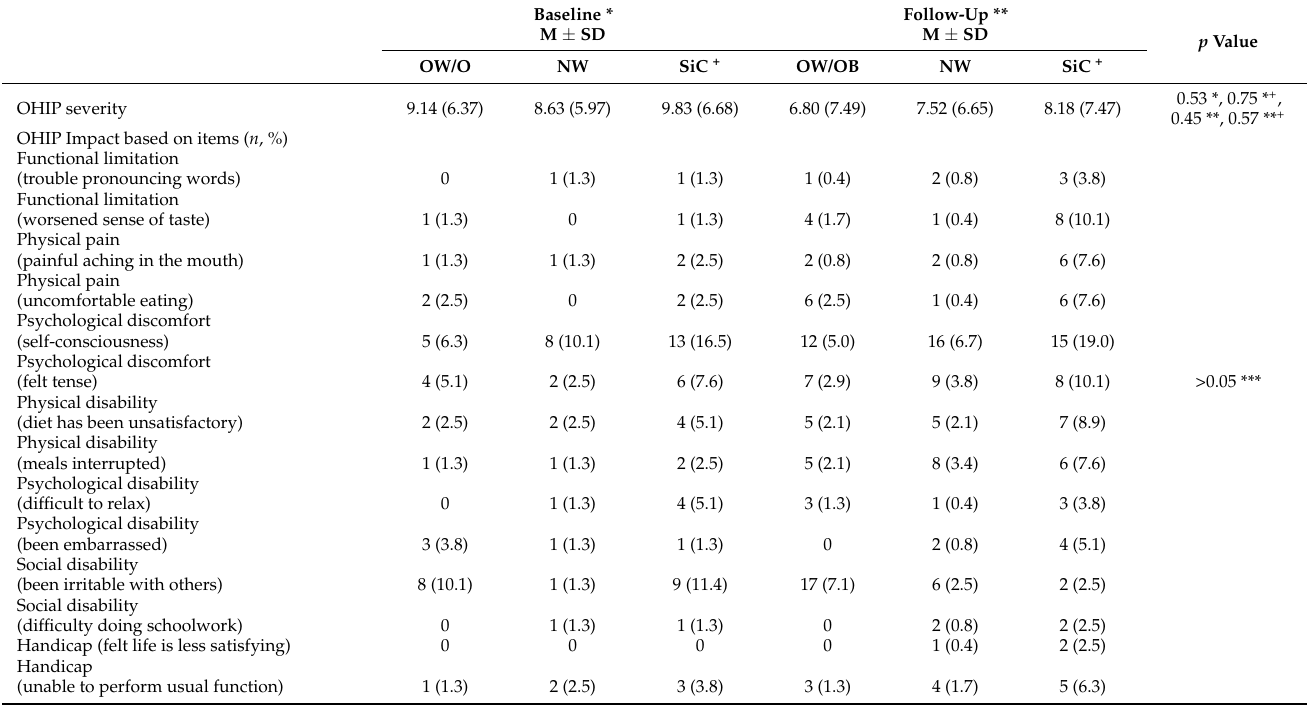
Table 4. Oral health related quality of life in obese, normal weight, and SIC groups at baseline and